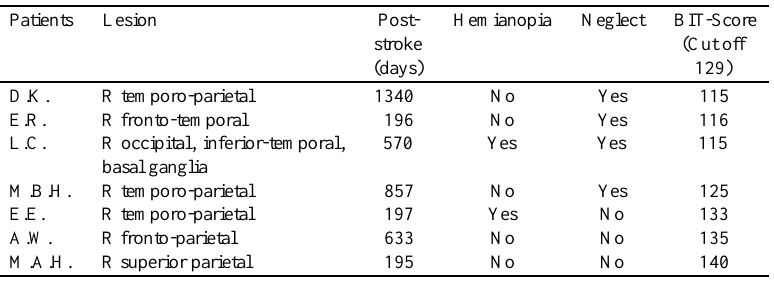
Table 1 Clinical data for the three patient groups. BIT-Score:Total score achieved in the Behavioural Inattention Test, conventional subtests (max. score 146, cut off 129) Patients Lesion Post-